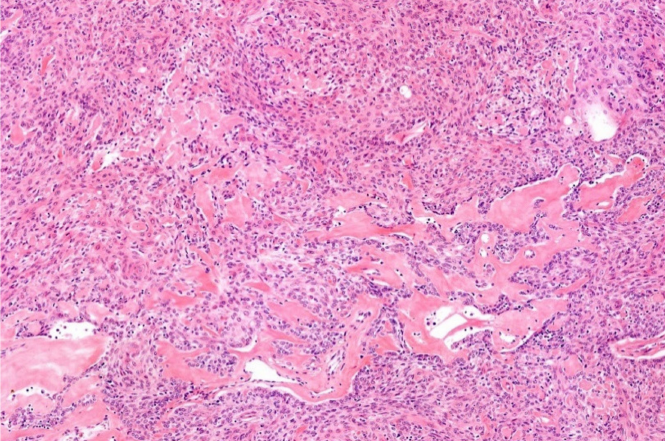
Figure 10. Myoepithelioma: epitheloid and spindle cells are arranged in sheets possessing bland looking nuclei. Note the prominent hyaline matrix (HE; 20 × magnification).